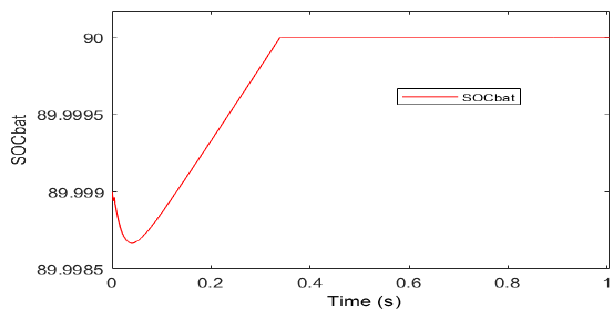
Figure 18. Battery SOC in